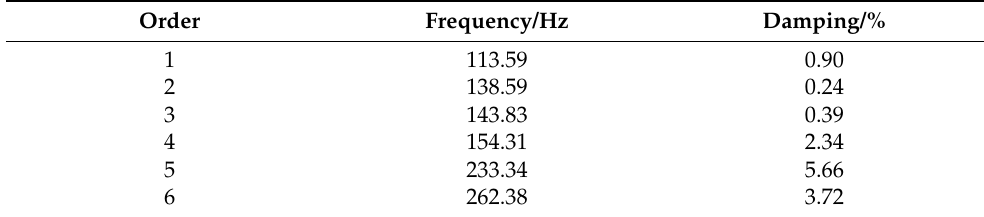
Table 1. First 6 natural